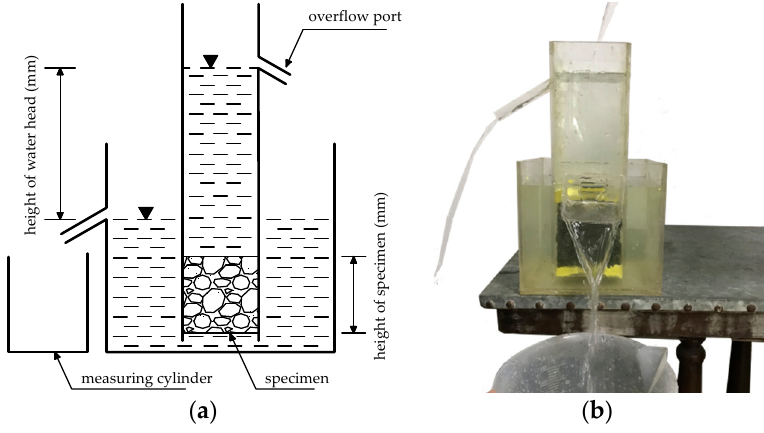
Figure 1. Permeability measurement: ( a ) permeability coefficient tester; ( b ) laboratory test.